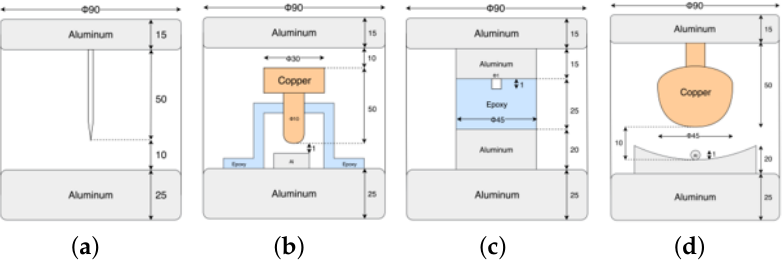
Figure 1. Artificial cells for the simulated ( a ) corona, ( b ) floating, ( c ) void, and ( d ) particle partial discharges